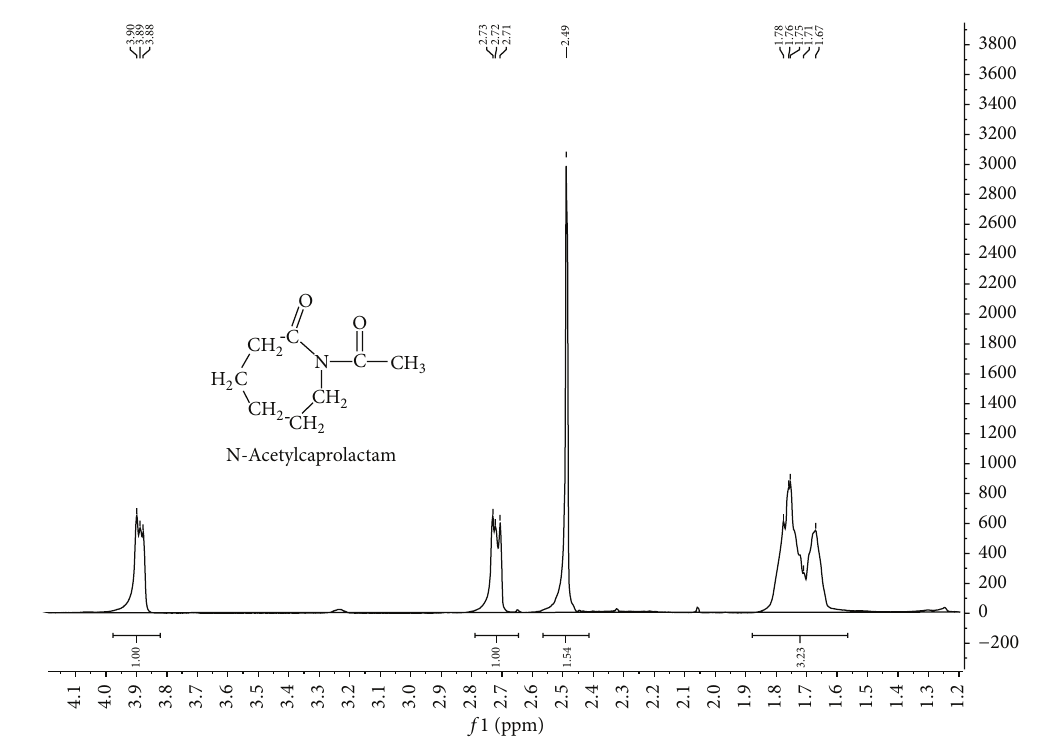
Figure 2: 1 H-NMR spectrum of N-acetylcaprolactam.